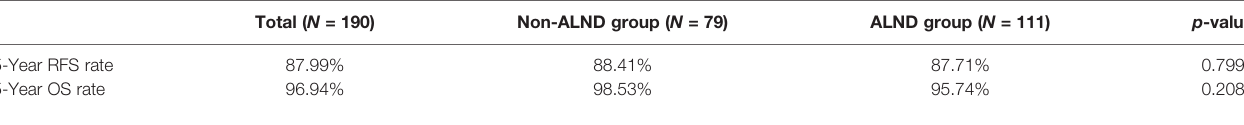
TABLE 3 | Five-year RFS rate and OS rate in the ALND and non-ALND groups. Total ( N = 190) ALND group ( N =